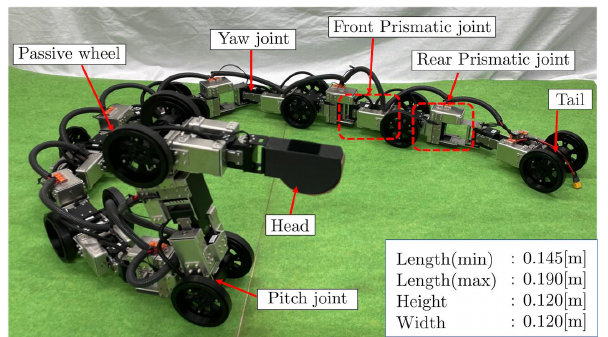
Figure 5. A snake robot with prismatic joints for experiments.